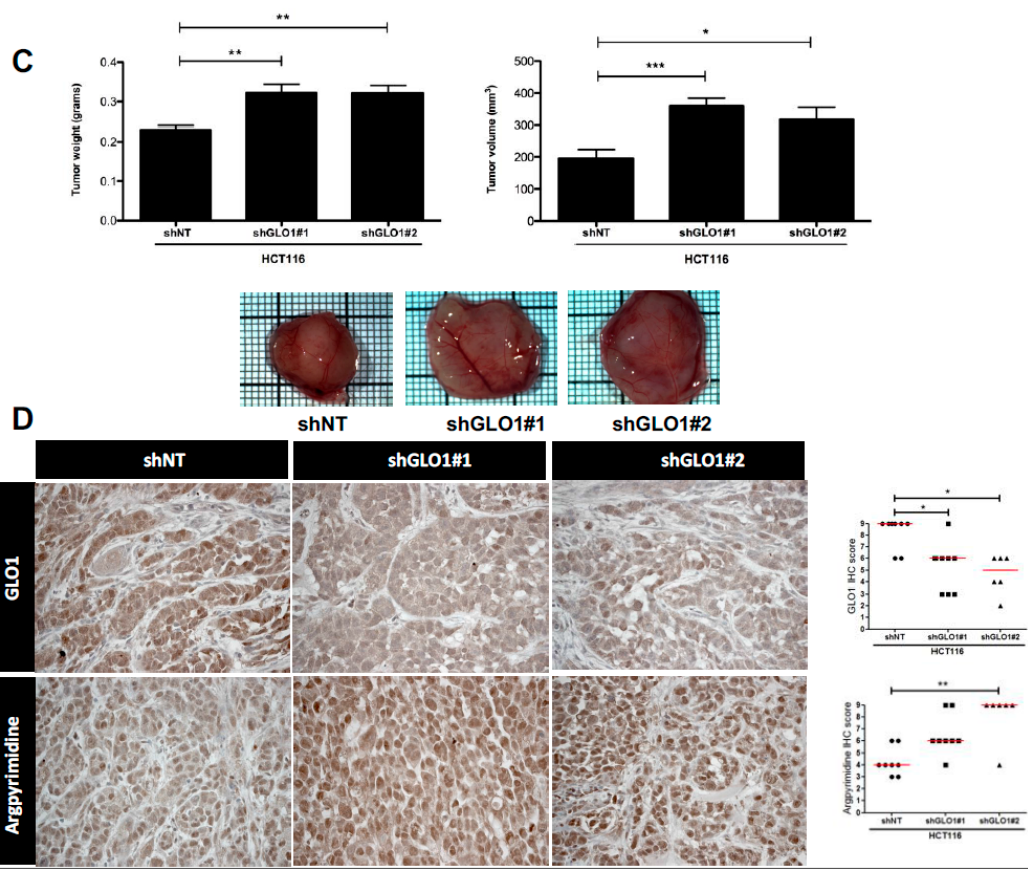
Figure 5. GLO1 depletion favors colorectal cancer cell growth in vivo. ( A ) The efficiency of GLO1 knockdown in HCT116 cells was validated by Western blot analysis; ( B ) Increased argpyrimidine level has been observed in GLO1 depleted cells compared with shNT control cells using Western blot analysis. β -Actin is shown as loading control; ( C ) Effect of GLO1 silencing on HCT116-derived tumor growth in chorioallantoic membrane (CAM) tumor model. The weight ( left ) and volume ( right ) of CAM experimental tumors collected at Day 7 is shown (at least 6 eggs/group). Data are shown as mean values ± SEM. Representative macroscopic tumor appearance is shown for each condition according to CAM experiment details are described in Material and Methods; ( D ) Representative GLO1 expression and argpyrimidine levels in CAM experimental tumors (400× magnification). IHC scoring for each is shown in panels on the right. Each dot represents one case and bars represent median. Statistical analysis has been performed using Bonferroni Multiple Comparison Test, * p < 0.05, ** p < 0.01, *** p < 0.001.